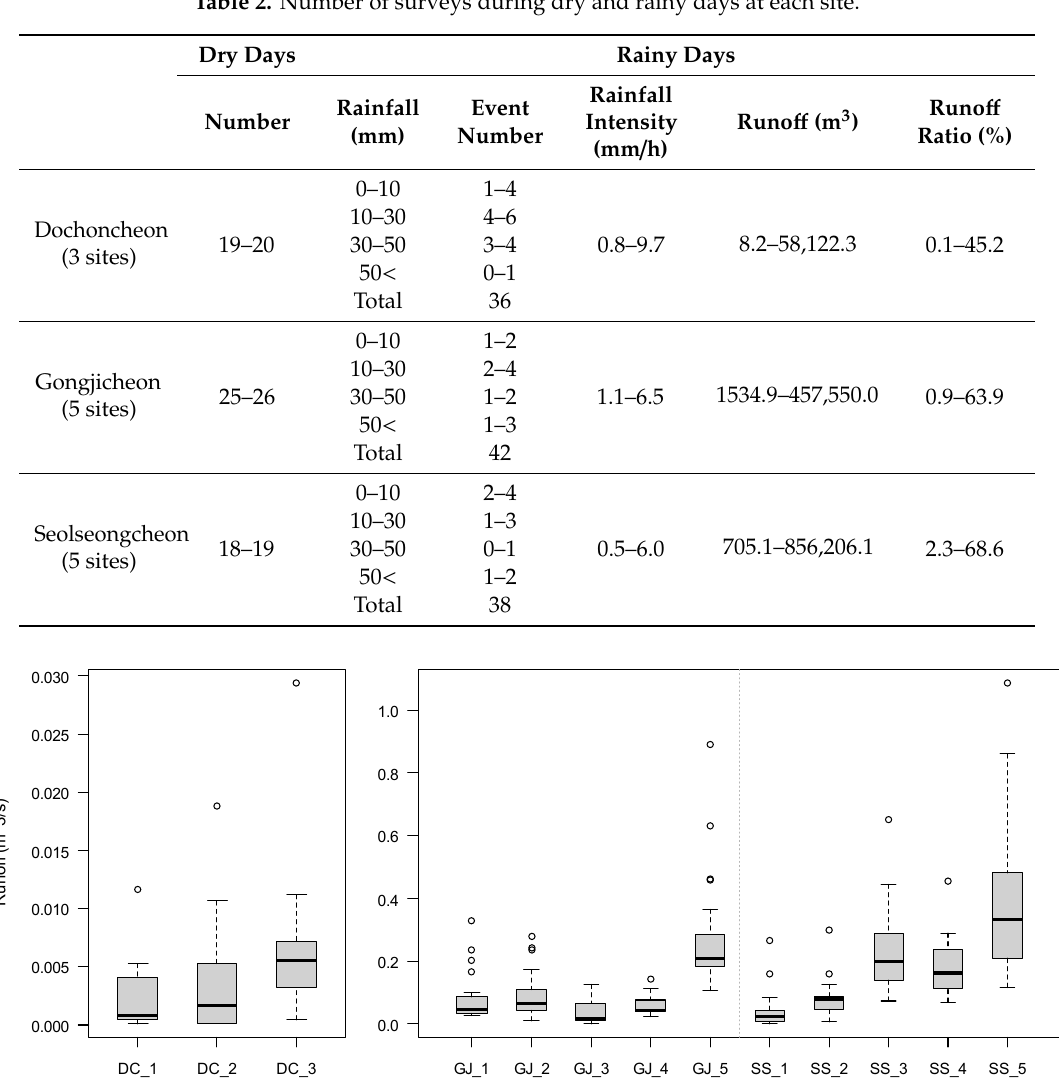
Figure 2. The runoff at each monitoring site during dry days over the monitoring period.